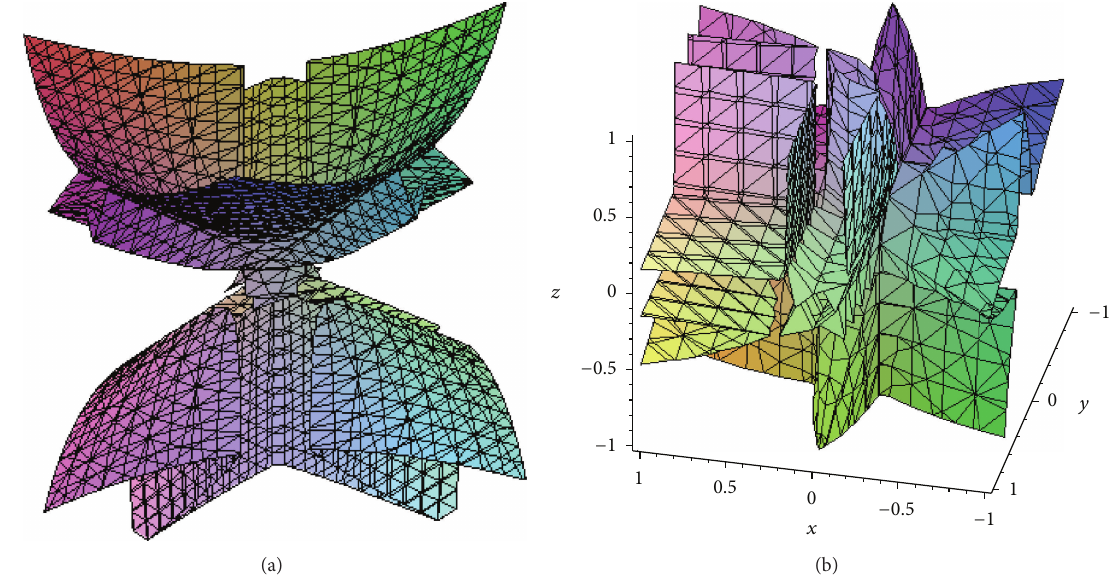
Figure 1: The boundary of instability of solutions of (70) constructed in the plane of parameters 𝑎 1 , 𝑎 2 , and 𝑎 3 for 𝑝 = 0 and for different values of 𝜌